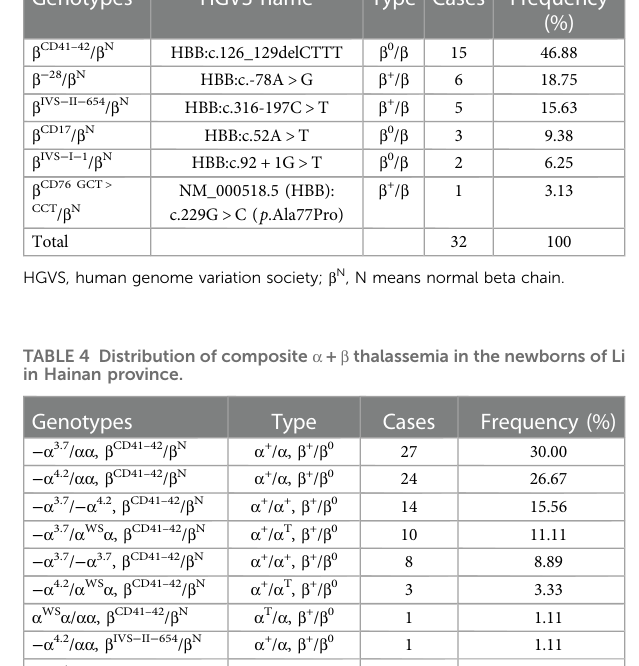
TABLE 3 Distribution of β -thalassemia genotypes in the newborns of Li in Hainan province. Genotypes